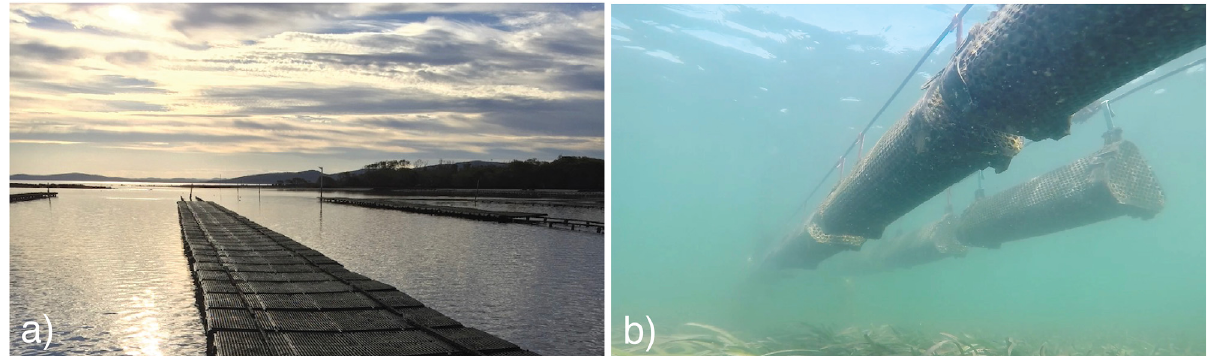
Fig. 2. Examples of oyster farm (a) rack-and-rail and (b) longlines-and-basket infrastructure in Port Stephens, New South Wales, Australia (source: F.